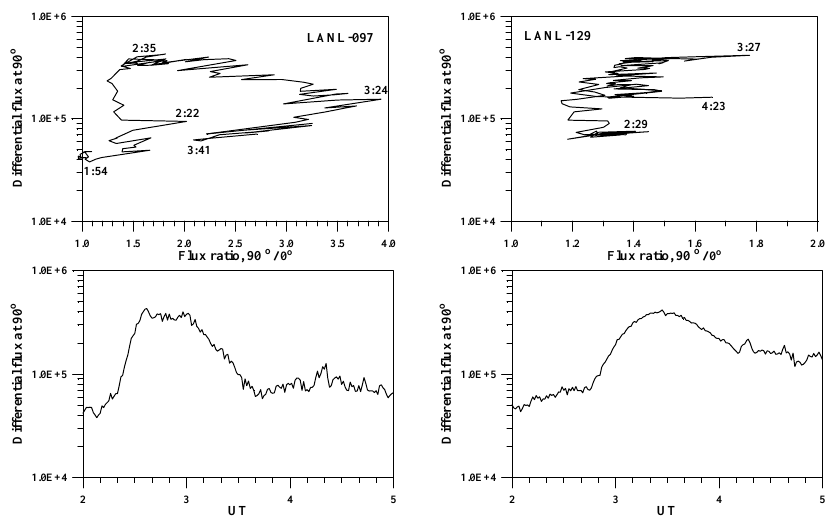
Fig. 5. The upper panels show the time trajectory in differential flux at 30–45keV across the magnetic field versus differential flux ratio at 90 ◦ /0 ◦ observed at two geosynchronous satellites. Time labels correspond to the times of the flux detection. The bottom panels show the corresponding flux at the 90 ◦ pitch angle.